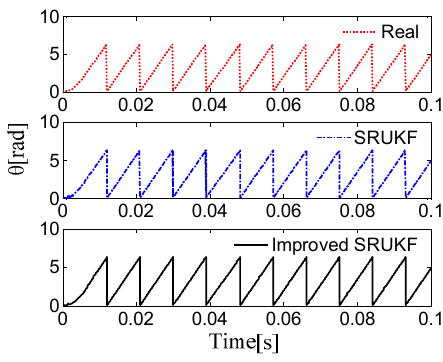
Figure 12. Space position estimation at load disturbance.